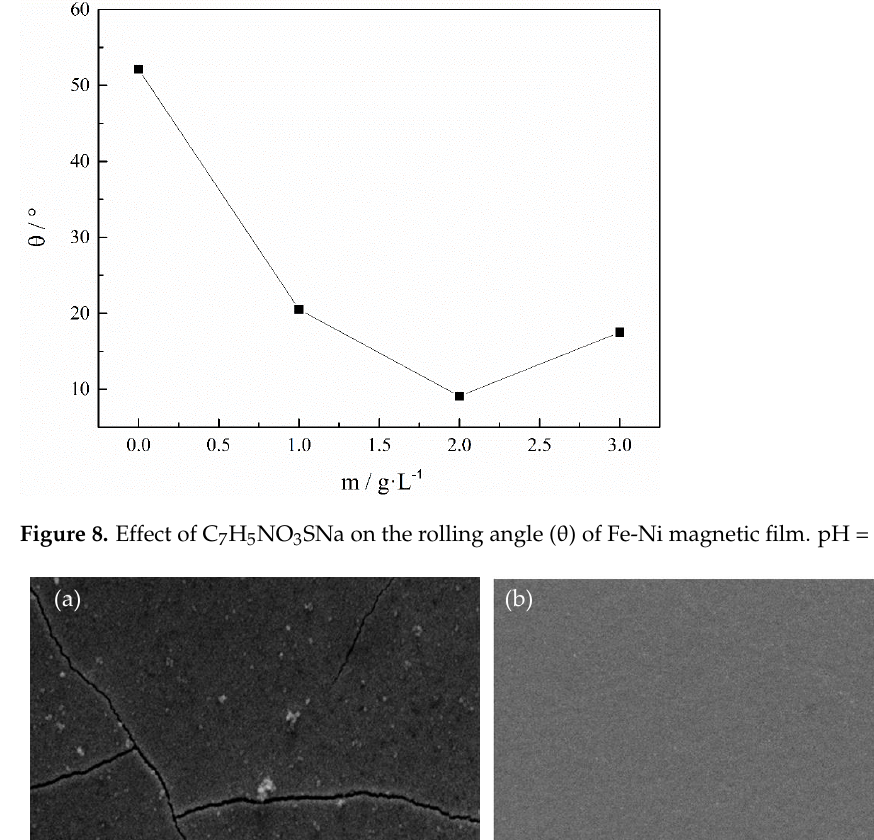
Figure 8. Effect of C 7 H 5 NO 3 SNa on the rolling angle ( θ ) of Fe-Ni magnetic film. pH = 2, 30 °C.